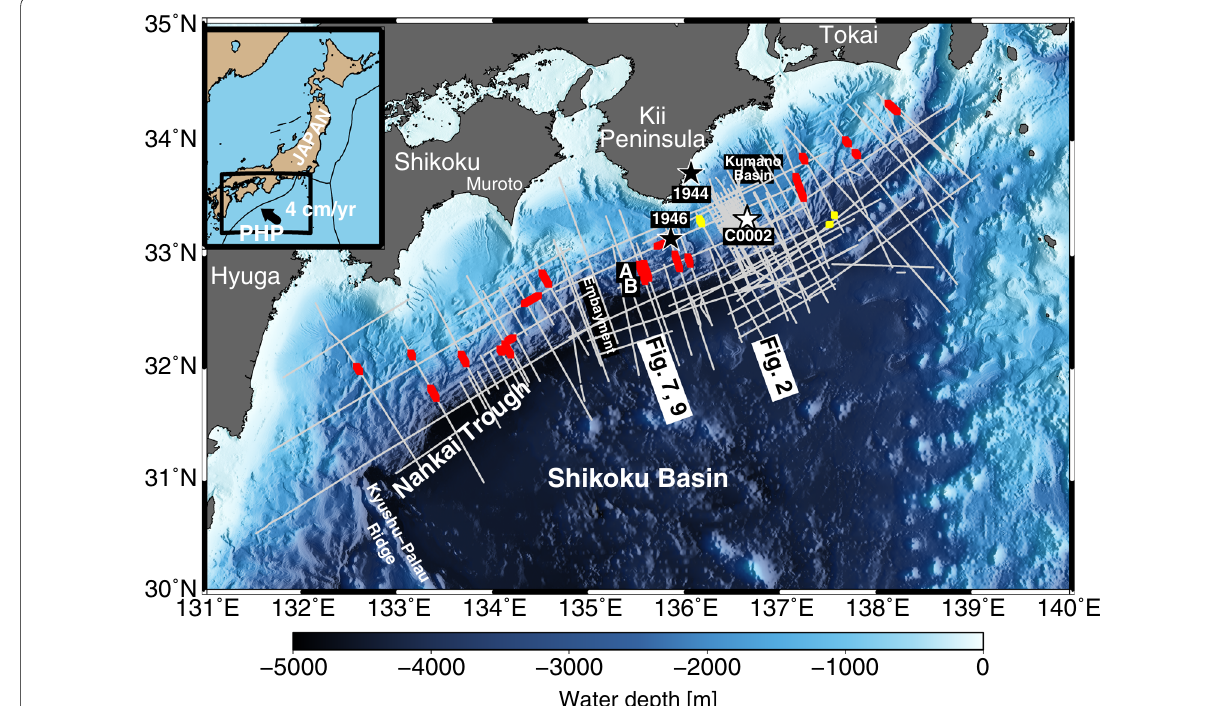
Fig. 1 Study area from offshore Tokai to Hyuga in the Nankai subduction margin. Gray lines represent the MCS reflection surveys studied in this work. Yellow dots represent the locations of BSRs identified in Figs. 2, 6b, c. Red dots denote the locations used to calculate the thermal structure via thermal modeling, which adopts the temperatures at the BSR depths as a constraint and, therefore, requires continuous BSRs (see Additional file 1: Figures S2 and S3 for more detail on the modeling section, and Figures S4–S23 for modeling results). Black stars indicate the epicenters of